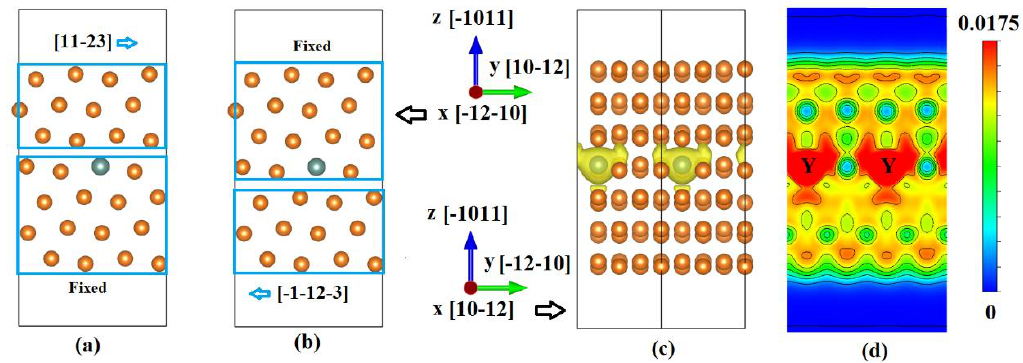
Figure 1. Atomic configurations for the {10-11} < 11-23 > slip system. A solute atom is substituted into the fourth plane for the Mg55X1 systems. The iso-surface level is 0.0175 a0 − 3 (a0: Bohr radius). ( a ) Slip mode I. The lower four layers of atoms are fixed; and the upper three layers of atoms are displaced along the 1 / 3[11-23] direction. ( b ) Slip mode II. The upper four layers of atoms are fixed; and the lower three layers of atoms are displaced along the 1 / 3[-1-12-3] direction. ( c ) Electronic structures of the Mg55Y1. Two periodic images are shown. The iso-surface level is 0.0175 a 0 − 3 (a 0 is Bohr radius). ( d ) A slice view of electronic structure of the Mg55Y1. Two periodic images are shown.